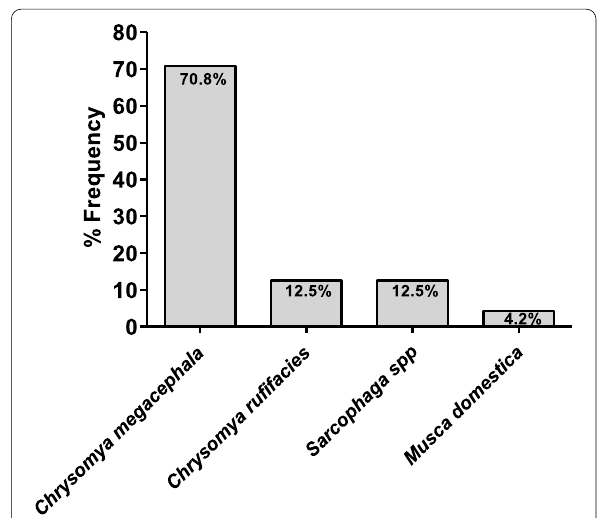
Fig. 6 Frequency of occurrence of necrophagous fly species of forensic importance in various medico-legal cases in Tamil Nadu State, India